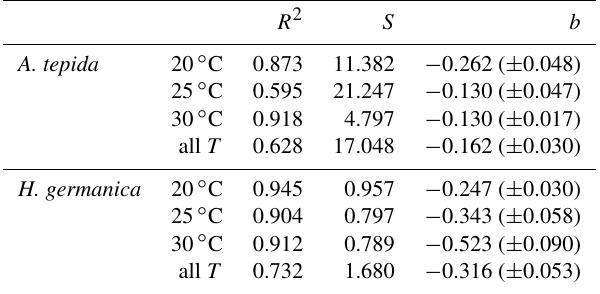
Table 3. Carbon uptake rates. Regression variables, correlation co- efficient R 2 , standard error of estimate S and decay b the exponen- tial decrease of carbon uptake rates of H. germanica and A. tepida versus